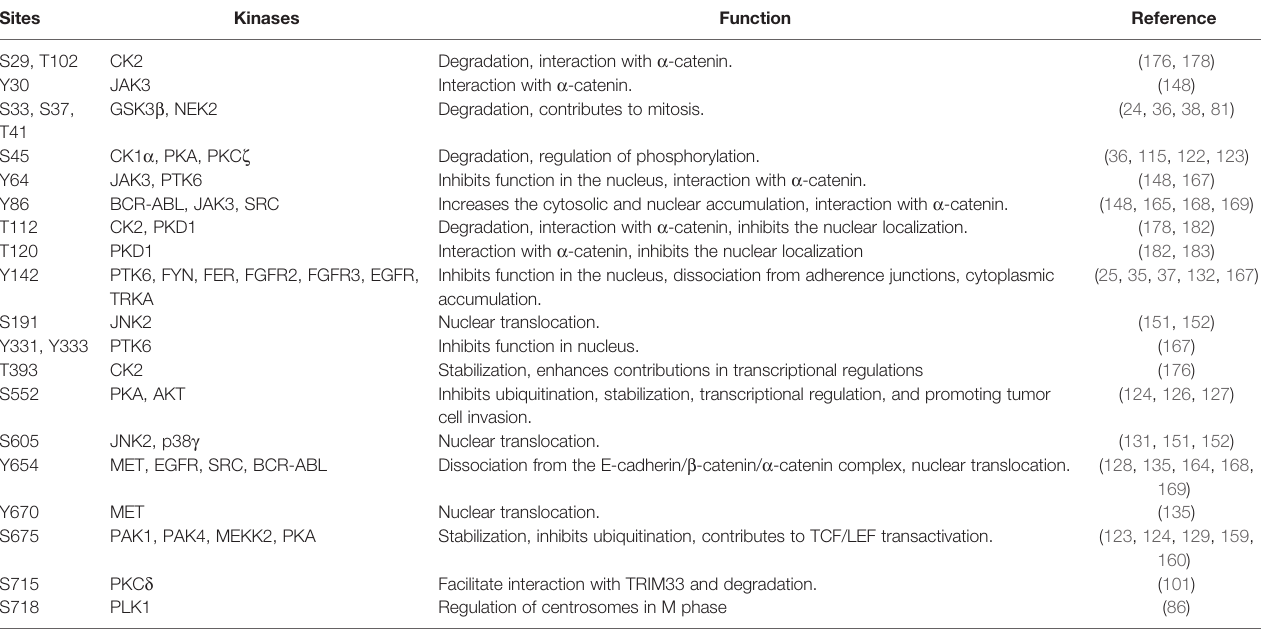
TABLE 1 | Kinases regulating b -catenin activity. Sites